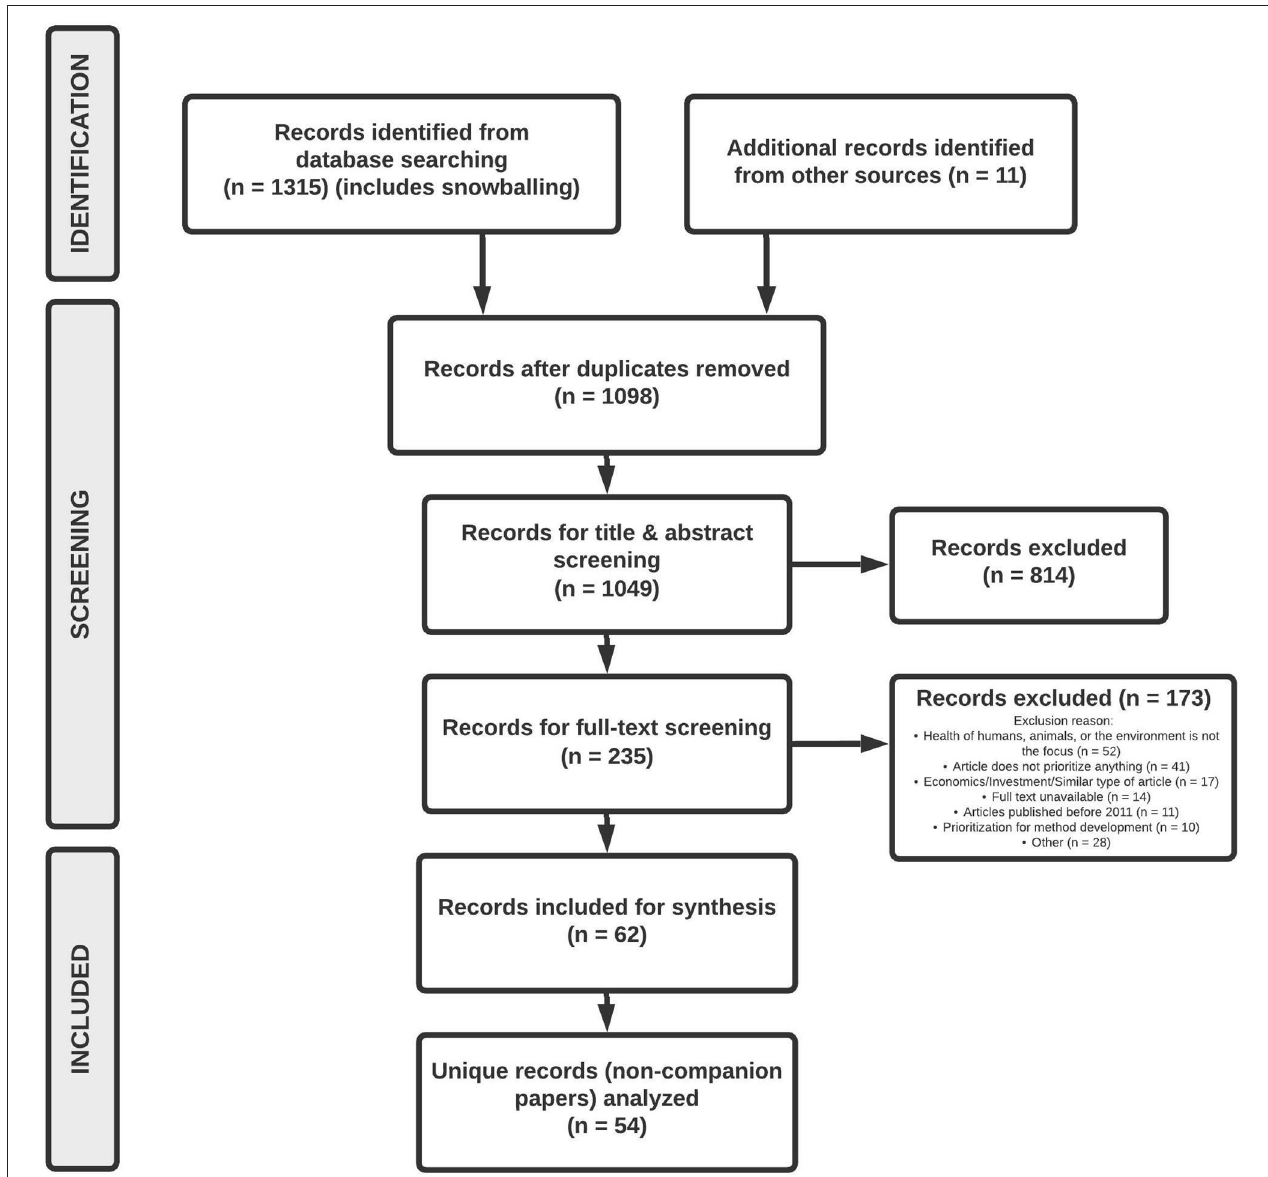
FIGURE 2 | Identification and screening of articles following the PRISMA flow